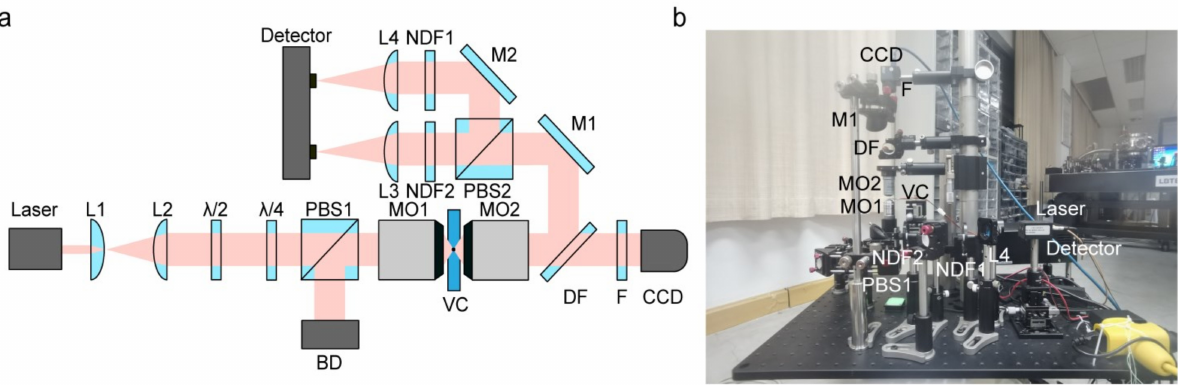
Figure 11. The experimental setup used for the trapping and rotation of a single vaterite particle in the microparticle vacuum chamber. ( a ) Schematic of the setup (L1–9, Lens; λ /2, Half-wave plate; λ /4, Quarter-wave plate; PBS1–2, Polarizing beam splitter; MO1–2, Microscope objective; VC, Vacuum chamber; DF, Dichroic filters; F, Filters; BD, Beam dump; M1–2, Mirror; NDF1–2, Neutral-density filters); ( b ) Image of the setup.